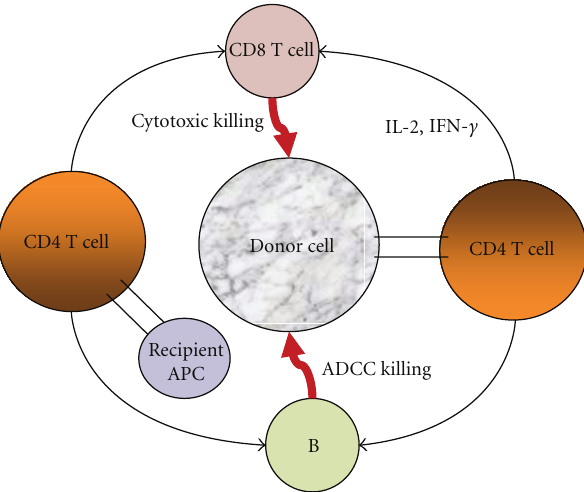
Figure 1: Mechanism of graft rejection. Allogeneic T cells recognize antigen through either a direct or an indirect pathway. In the direct pathway, T cells recognize intact allogeneic antigen on the surface of donor-derived APCs. This pathway is thought to predominate in acute rejection. In the indirect pathway, recipient APCs process donor-derived alloantigen into peptides and then present them to recipient T cells. This pathway is thought to dominate chronic rejection. The activation of T cells through either pathway results in killing the donor